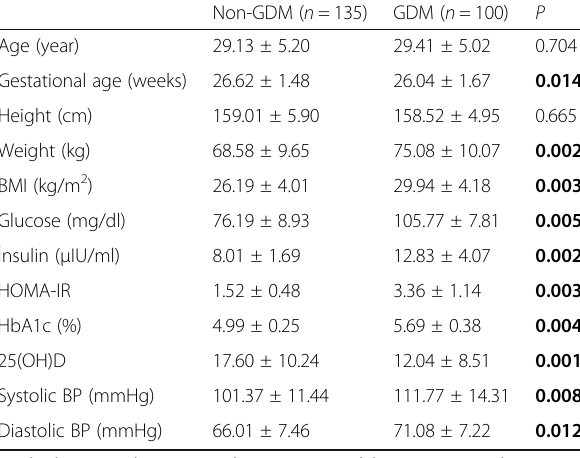
Table 1 Characteristics of